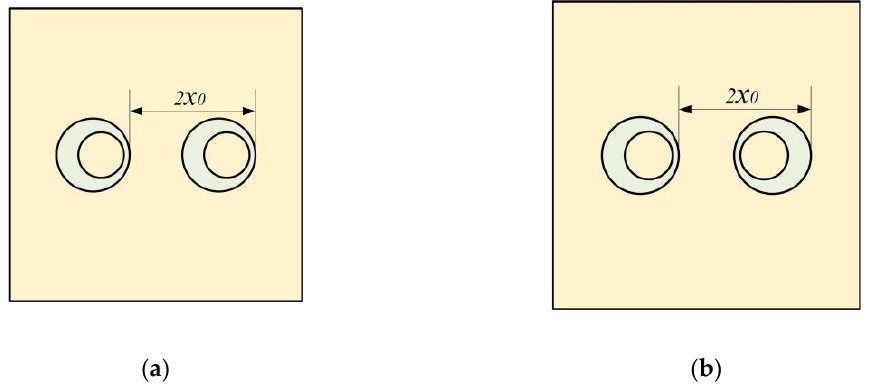
Figure 5. Definitions for the configuration of the MAM loaded with two masses: ( a ) asymmetric arrangement and ( b ) symmetric arrangement.